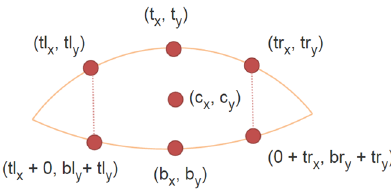
Figure 9. Eye model using seven control points (12 values) that generates two intersecting parabolas.